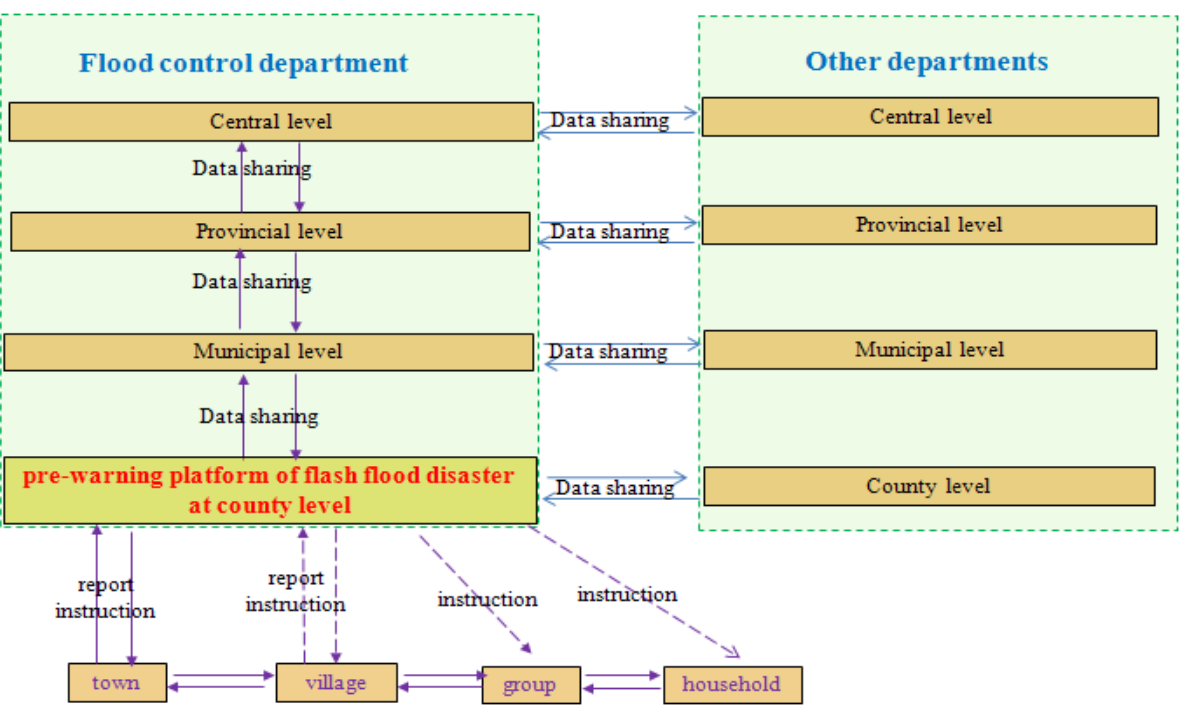
Figure 3. Overall structure of non-structural measures construction for flash flood disaster prevention